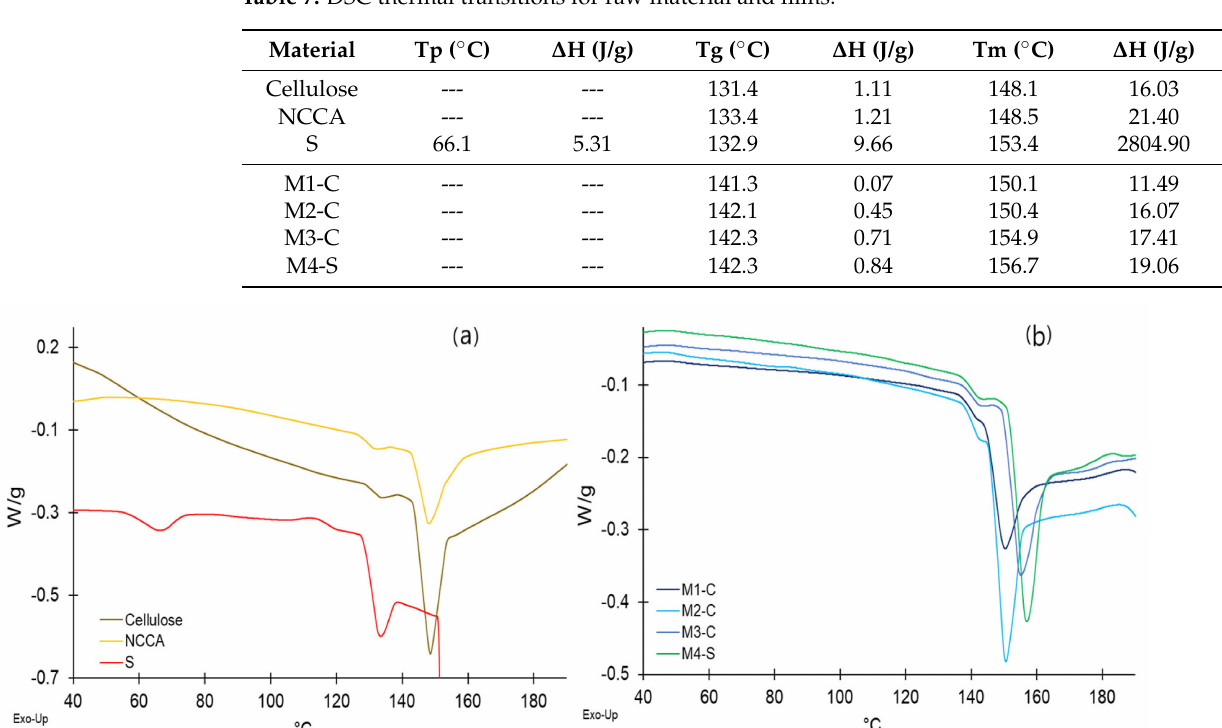
Table 7. DSC thermal transitions for raw material and films.